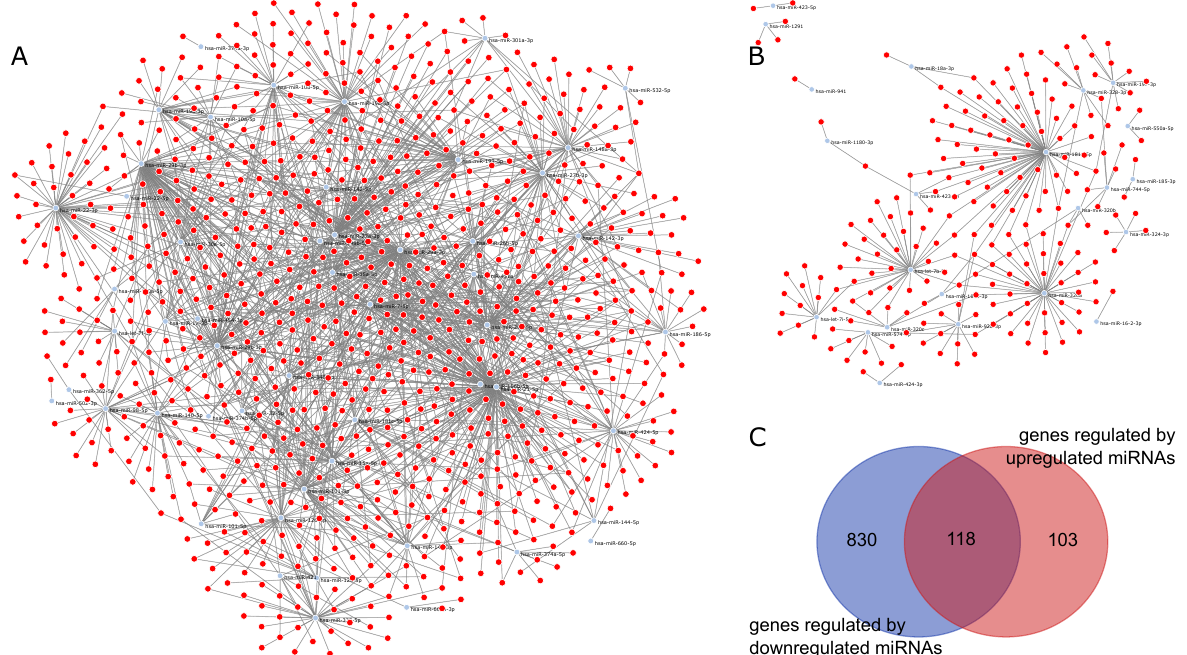
Figure 4. miRNA–gene networks for MS vs. EC generated by ncRNA-network tool: ( A ) graphical representation of the miRNA–gene network of downregulated miRNAs in MS vs. EC; ( B ) graphical representation of the miRNA–gene network of downregulated miRNAs in MS vs. EC; and ( C ) Venn diagram of genes regulated by downregulated miRNAs and upregulated